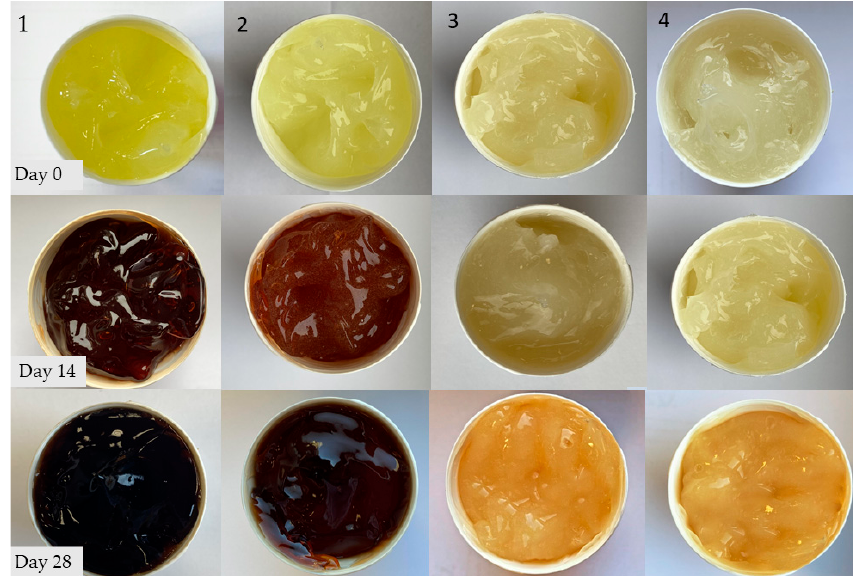
Figure 2. Colour changes of hydrogel preparations ( 1 – 4 ) noted during the 28-day observation